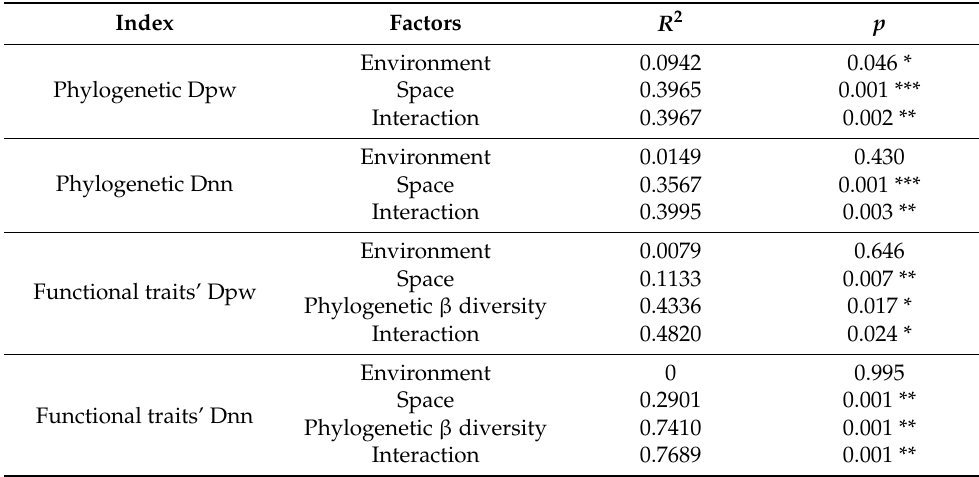
Table 2. MRM of beta diversity of phylogenetic and functional